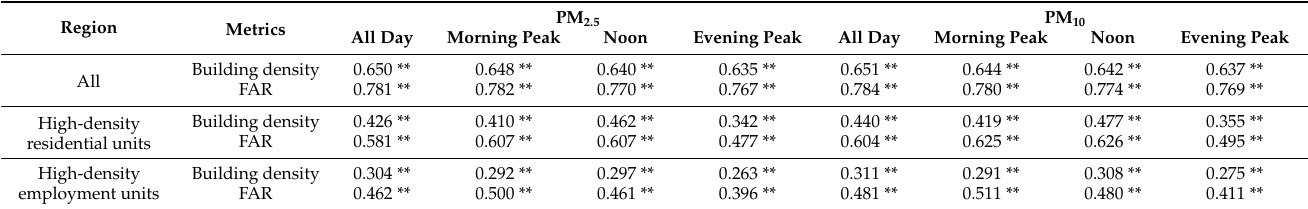
Table 2. Correlation between air pollution exposure, building density, and